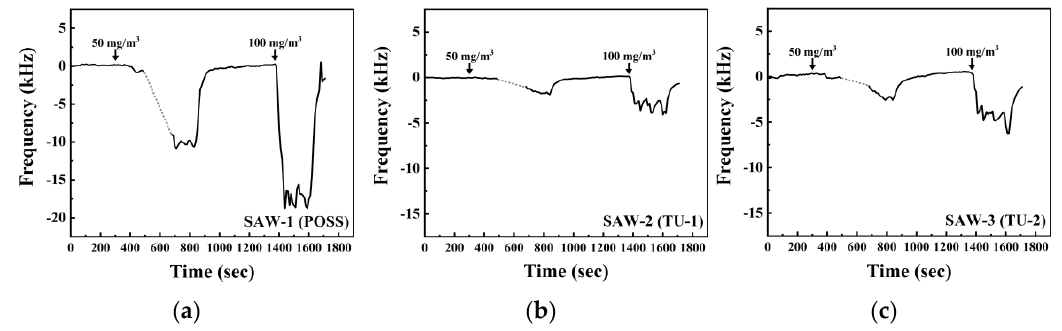
Figure 6. Dynamic response of the SAW sensors coated with different sensing materials: ( a ) POSS; ( b ) TU-1; and ( c ) TU-2 upon exposure to GA concentrations ranging from 50 to 100 mg/m 3 . The inserted numbers are the different concentrations of GA.